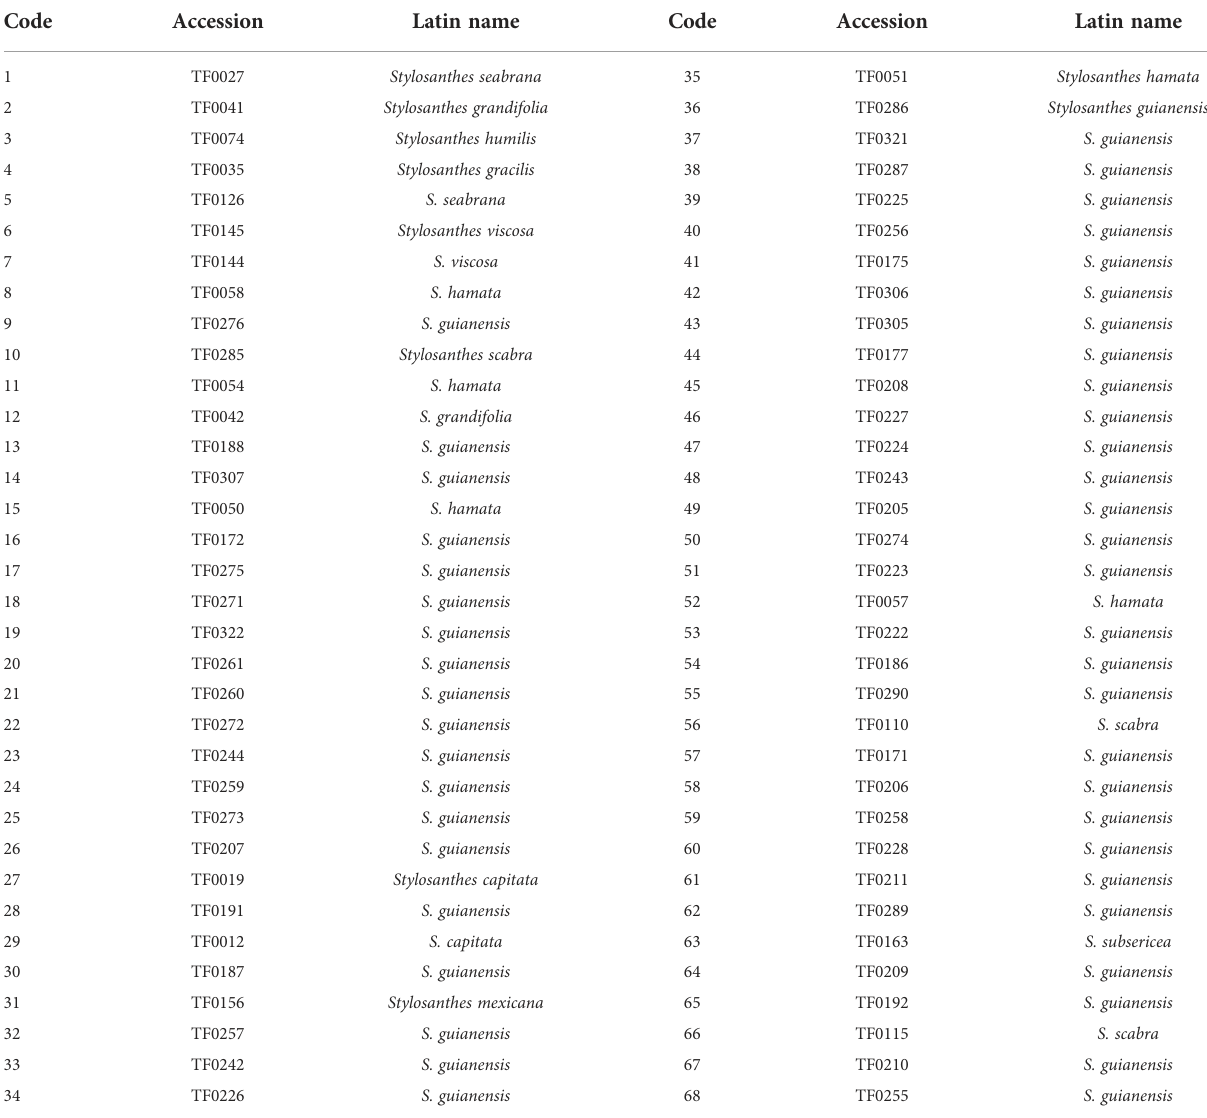
TABLE 1 Sixty-eight stylo accessions used in this